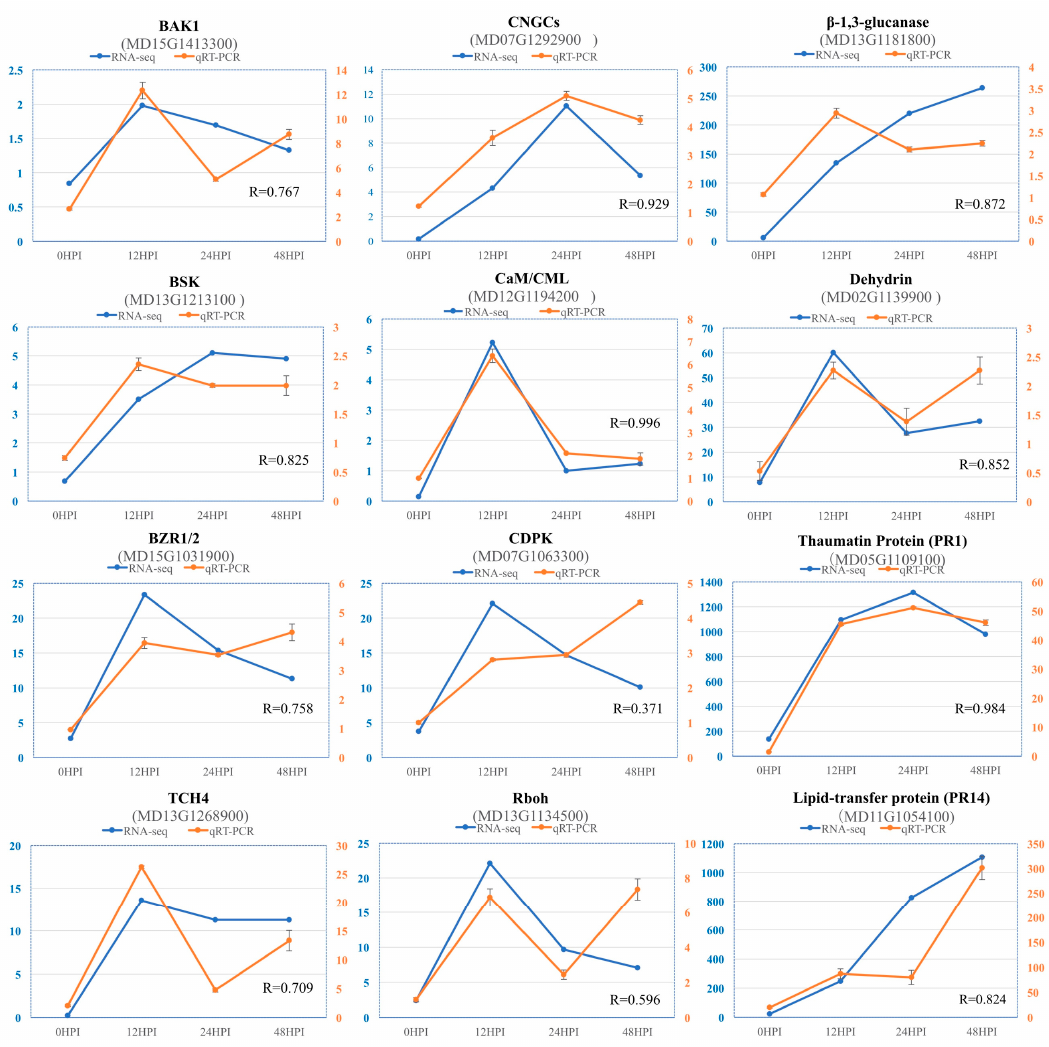
Figure 5. Comparison of the relative expression level change of 12 selected DEGs by RNA-seq and qRT-PCR. Left vertical axis coordinate is FPKM of RNA-Seq (blue); right vertical axis coordinate is relative expression level of qRT-PCR (red). R-values are relative coefficients between qRT-PCR and RNA-seq.